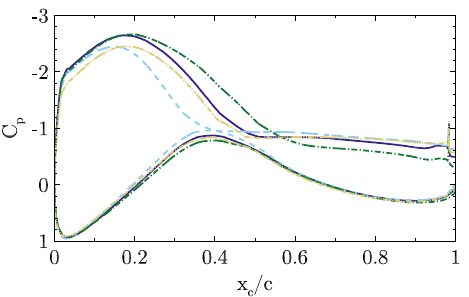
Figure 25. Airfoil pressure distribution at r/R = 0 . 136 for CaseT1.4 (solid), CaseT1.4-dXm04 (dashed dot dot), CaseT1.4-dYm05 (dashed dot) and CaseT1.4-dYp05 (dashed).